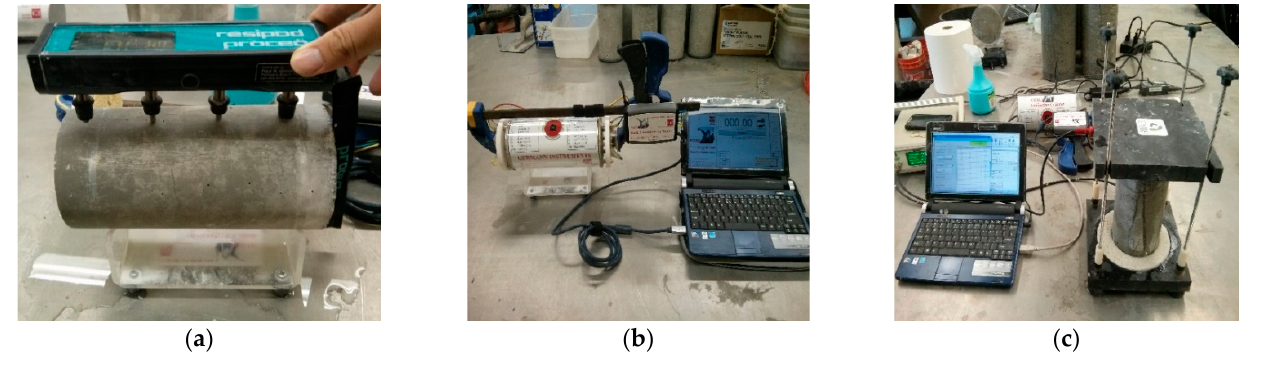
Figure 1. ( a ) 4 point Wenner probe ( b ) Merlin meter and ( c ) RCON tester.